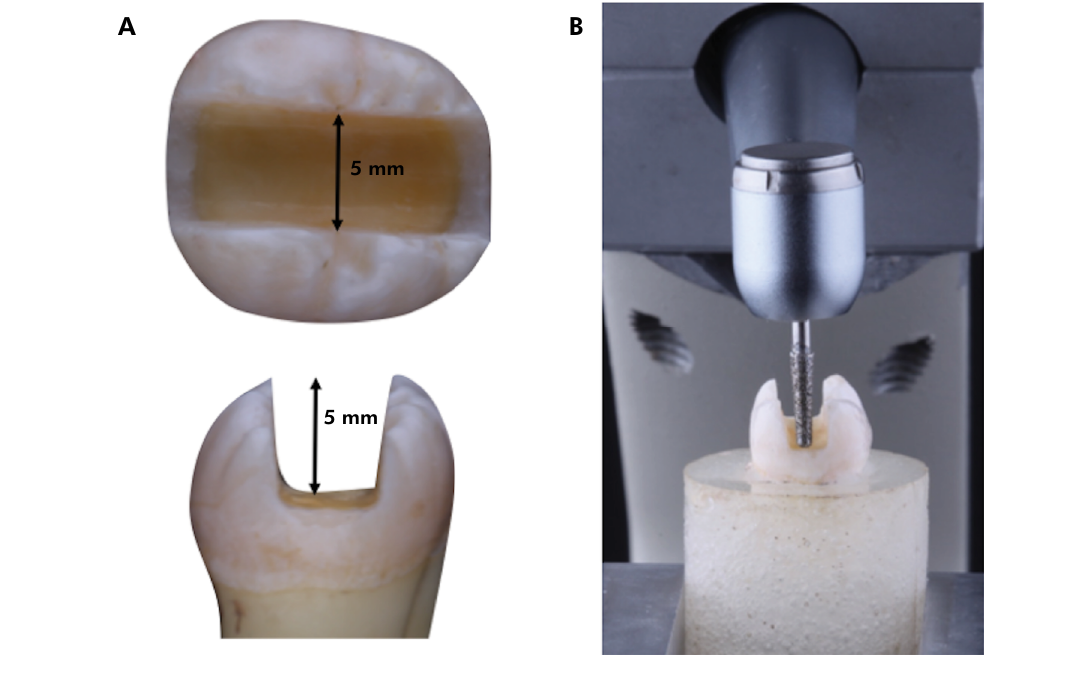
Figure 1. Tooth preparation and preparation machine. (A) Standard large MOD cavity and corresponding measurements. (B) Specimen during preparation positioned on the preparation